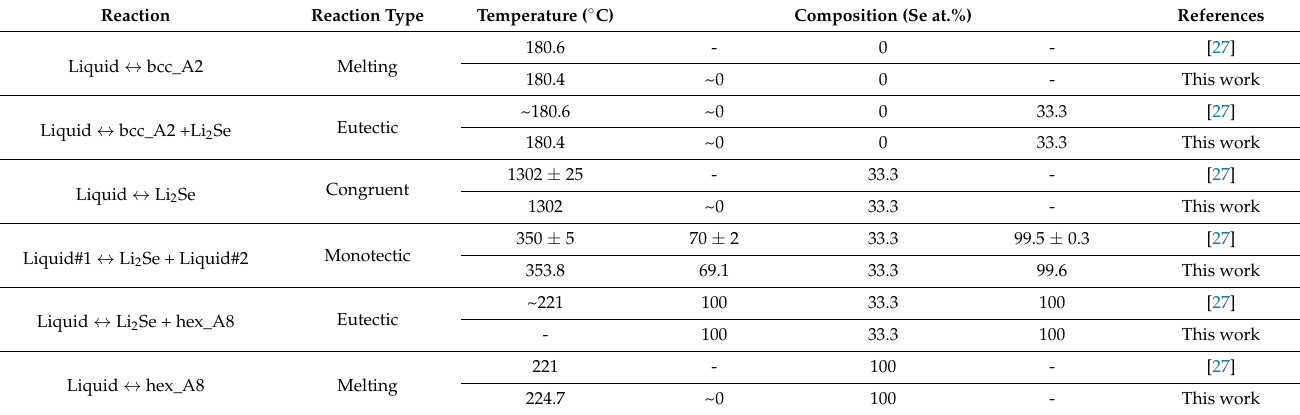
Table 5. Calculated invariant reactions in the Li-Se system compared with experimental data